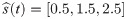
The step responses of the robot manipulator with 9 different uncertainty scenarios (s^(t)=[0.5,1.5,2.5] and α~=[-0.05,0,+0.05]) for θ = 0.25, θ = 0.5 and θ = 0.75.